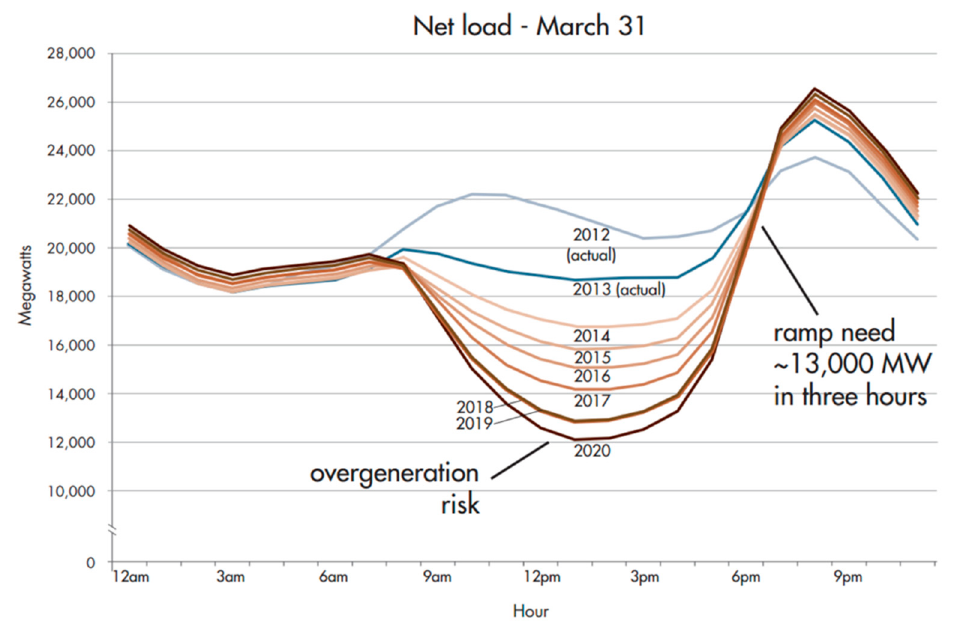
Figure 5. California Independent System Operator Duck Curve [35].